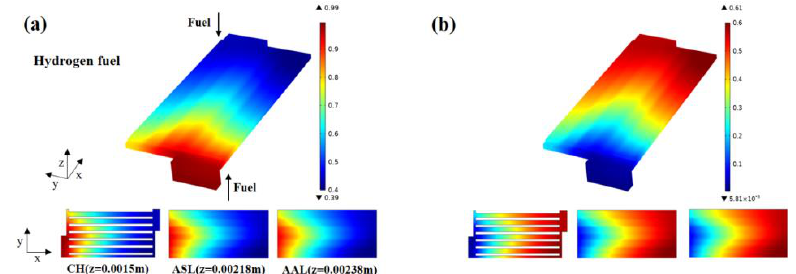
Figure 5. Molar fractions of hydrogen SOFC for: ( a ) H 2 ; ( b ) H 2 O.